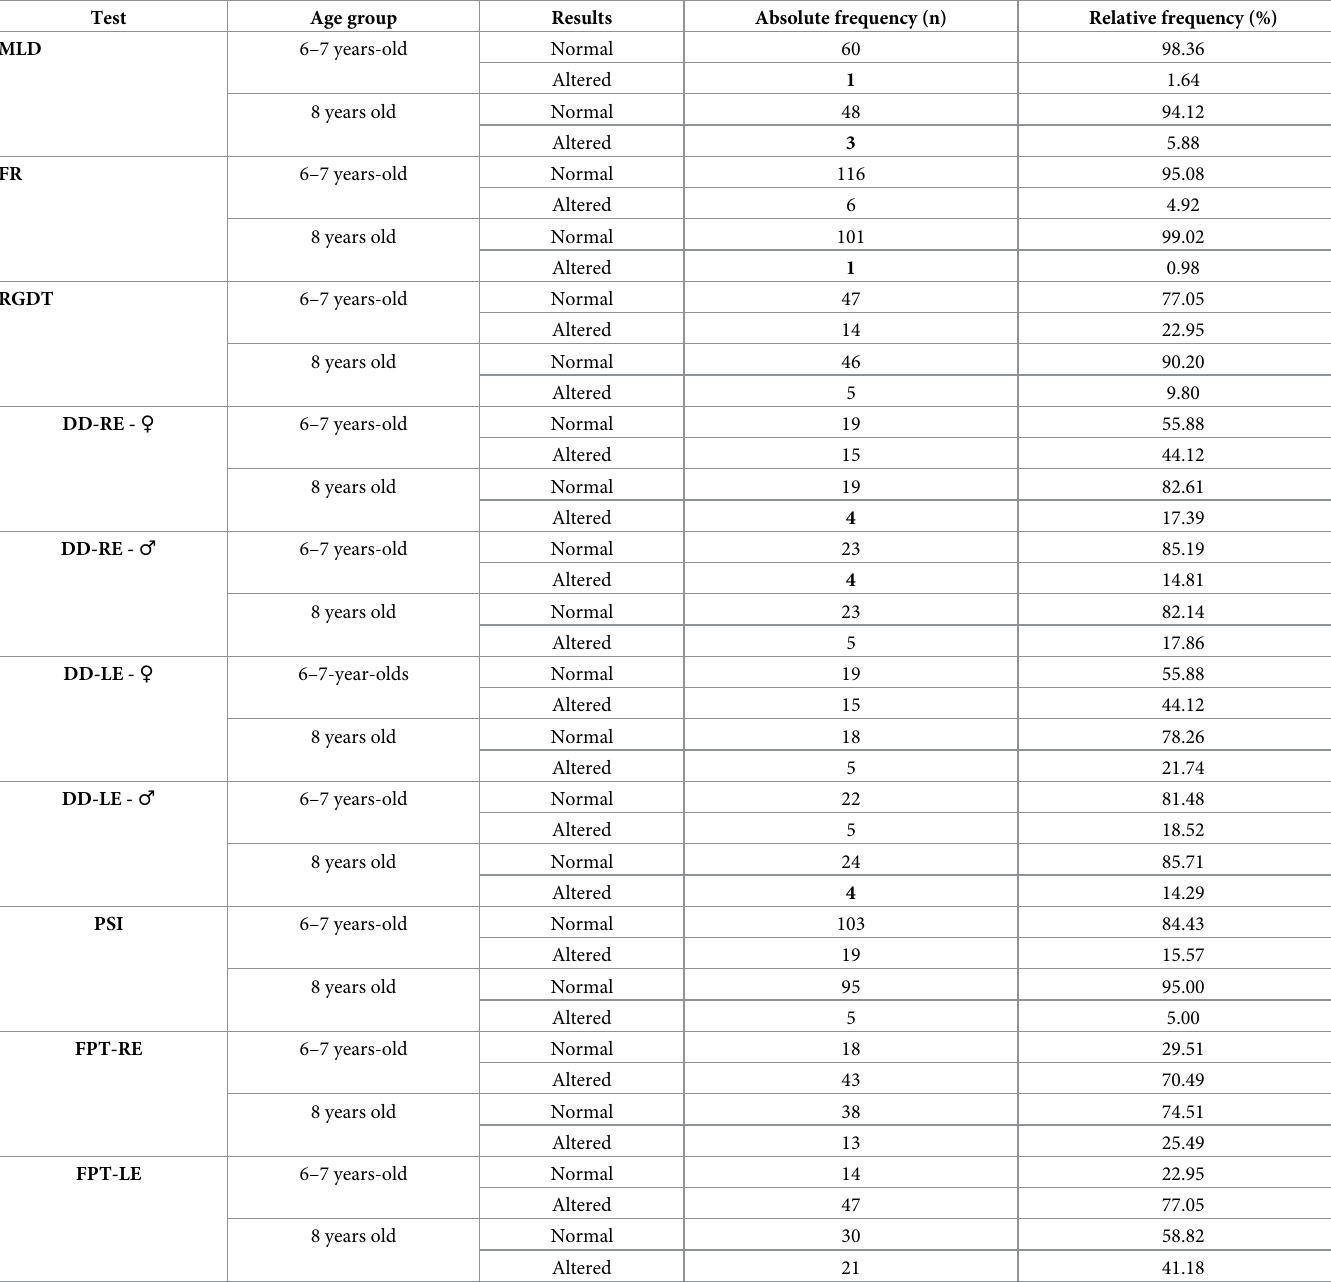
Table 2. Performance of schoolchildren in the central auditory processing behavioral